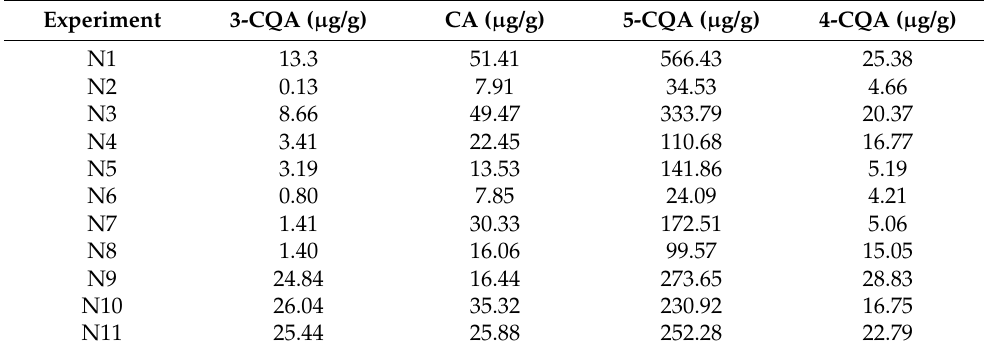
Table 4. Phenolic acid content ( µ g/g) in a fresh sprout sample extracted according to the conditions of Experimental